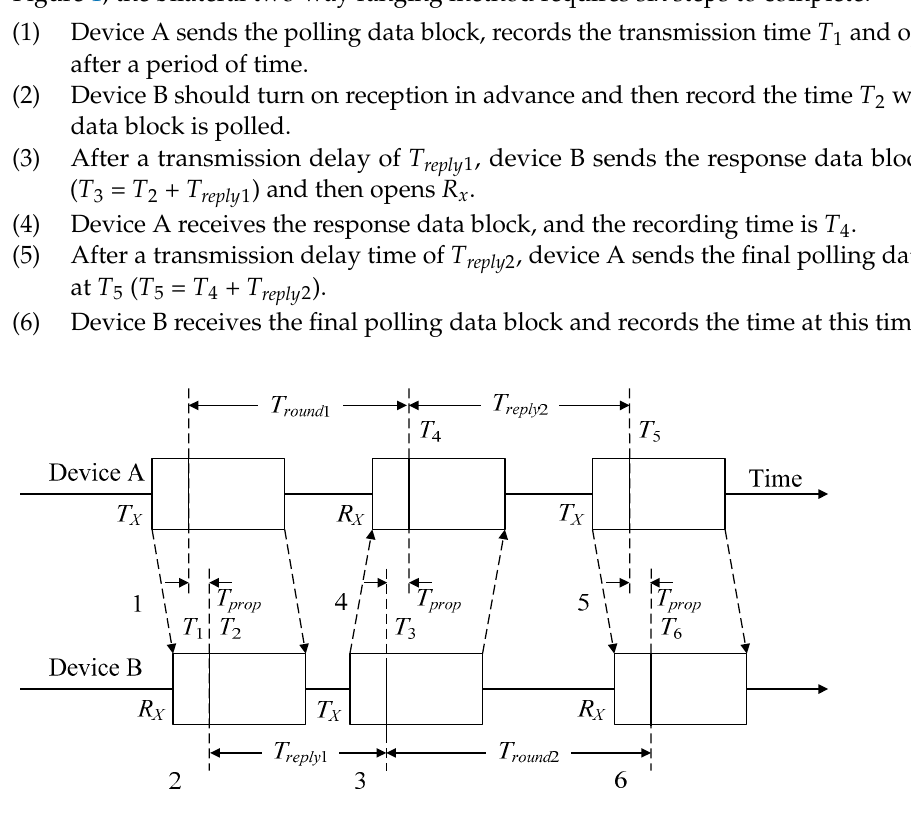
Figure 1. UWB bilateral two-way ranging